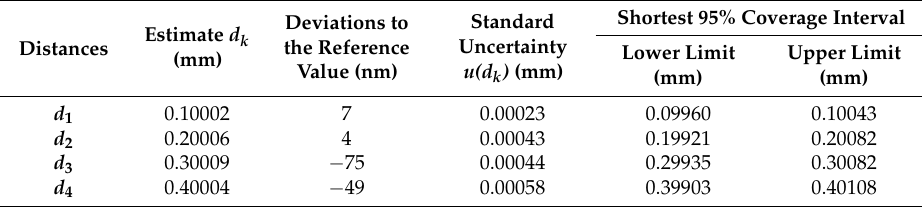
Table 4. Measurement results of the glass line scale in horizontal position. Hypothesis